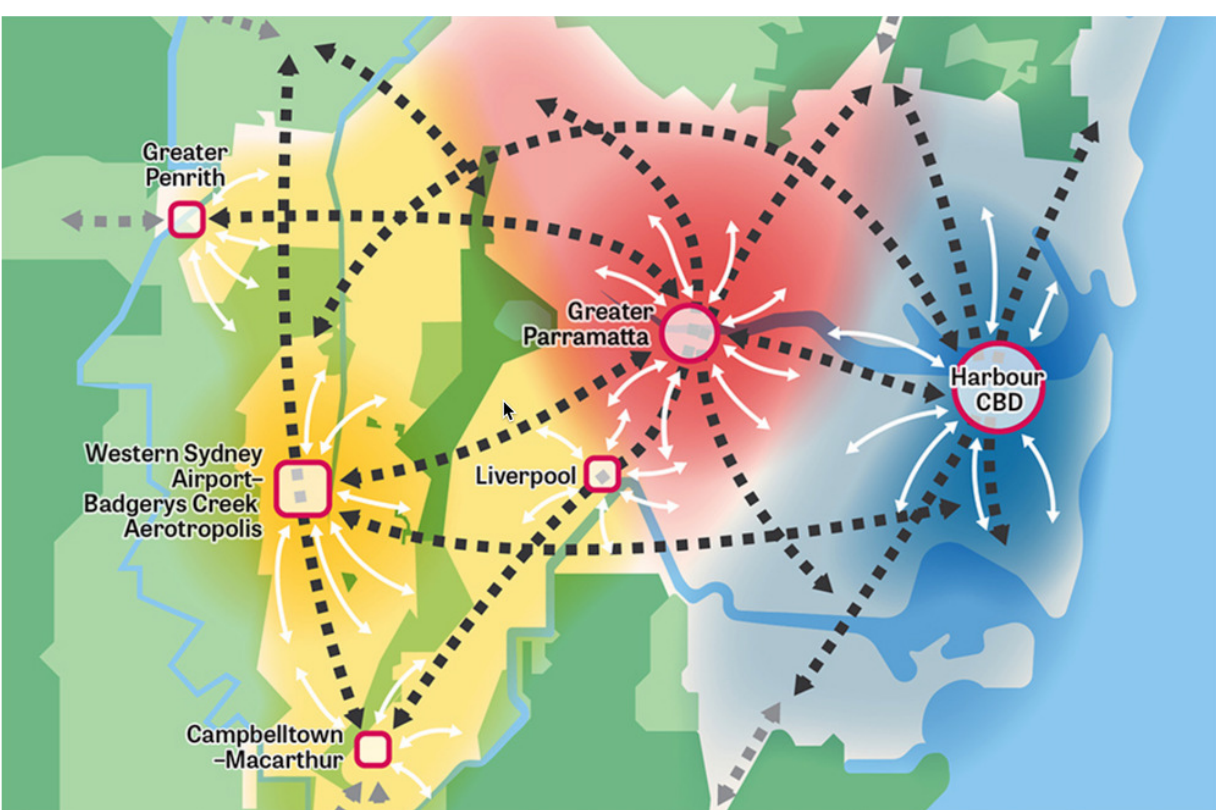
Figure 1. The Greater Sydney Commission’s three cities plan. Source: Greater Sydney Commission (2018, p. 7). of which the suburb of Sydney is the CBD and home to most economic exchange and office work